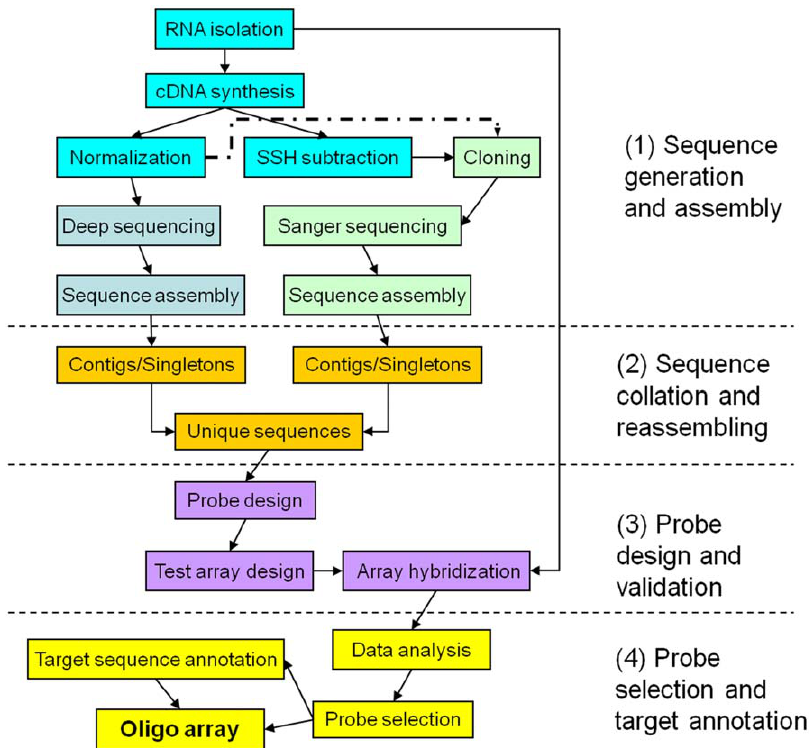
Figure 1. Oligo array design process. Our proposed easy-to-follow approach to design, validation and annotation of microarray oligo probes particularly for organisms with unsequenced genome but having a transcriptomic scale of EST sequences generated with deep sequencing and Sanger sequencing technologies. The SSH subtraction is optional as many researchers often construct normalized cDNA libraries for cloning and Sanger sequencing.